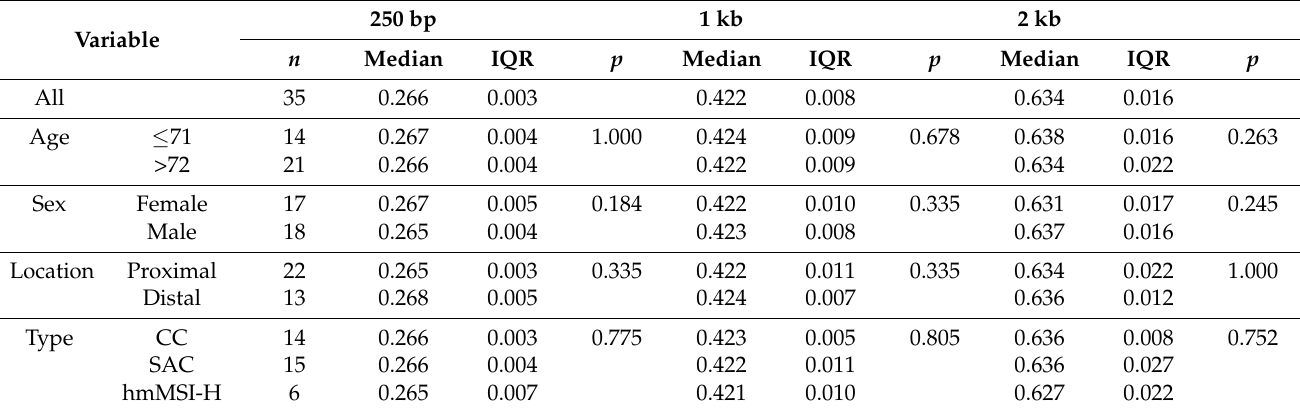
Table 2. Associations between global methylation scores of normal adjacent mucosa and demographic and clinic- pathological features of the study